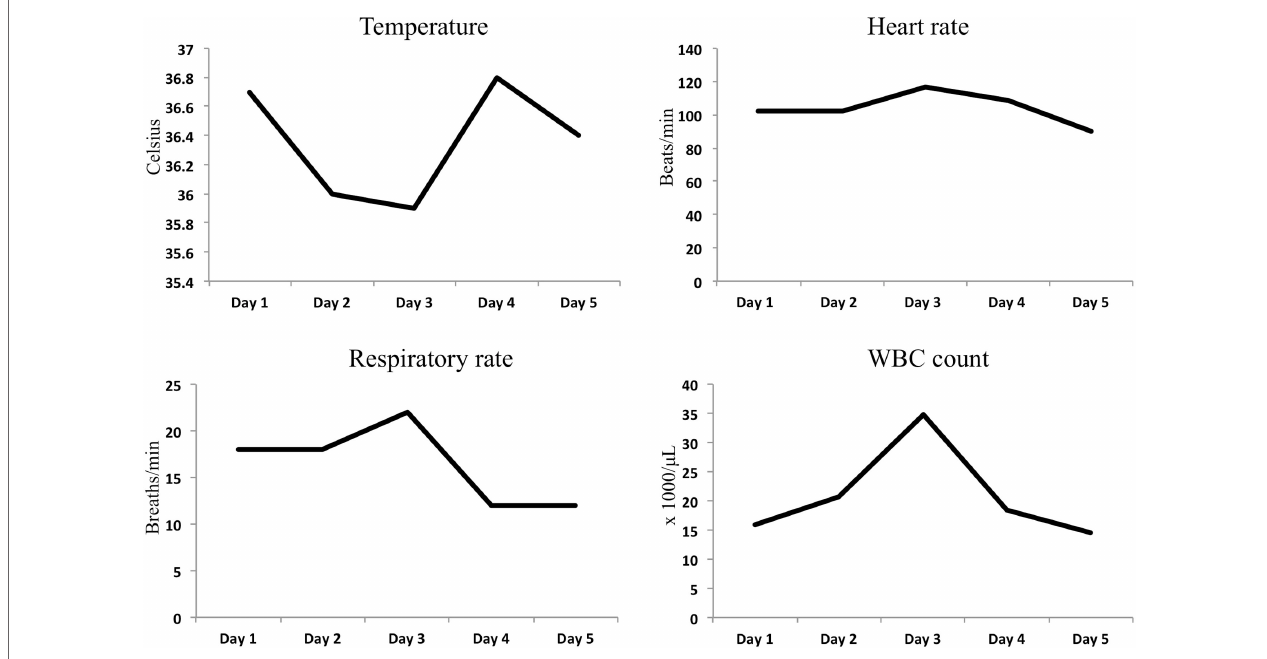
FIGURe 1 | Graphical representation of sIRs criteria trends during ICU stay